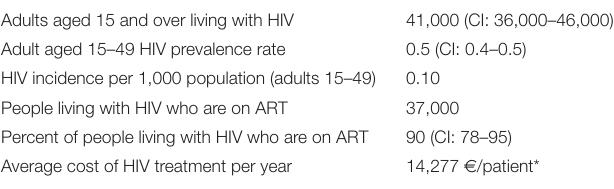
TABLE 1 | HIV/AIDS estimates in